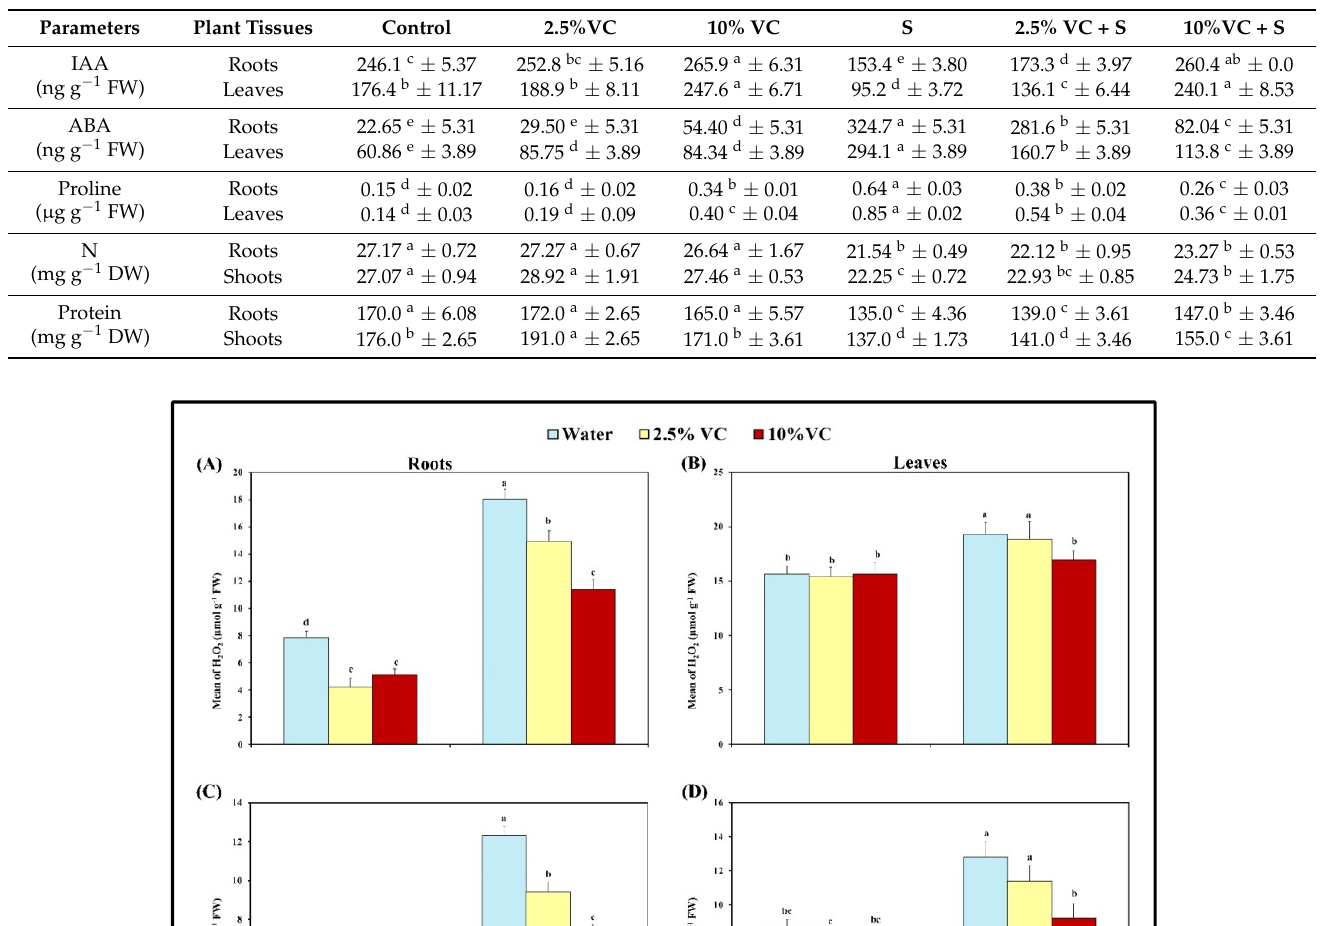
Table 4. Effect of 0, 2.5 and 10% vermicompost, 200 mM NaCl (S) and their interactions on the contents of indole acetic acid (IAA), abscisic acid (ABA), proline, nitrogen (N) and protein in the roots and shoots of Vicia faba plant after 30 days of cultivation. Values are means ± SD based on triplicate independent determinations, and different letters means significant difference as evaluated by Duncan’s multiple comparison test ( p < 0.05).